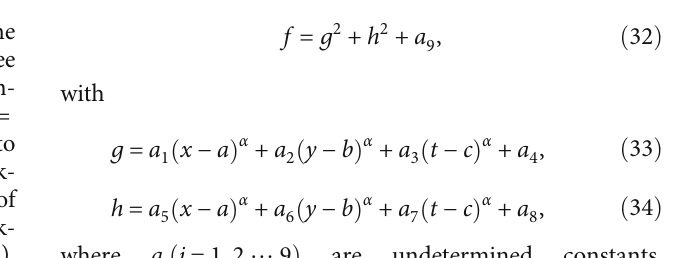
0 Þ = 0 , ξ ð 0 Þ = 0 , and ξ ð 0 Þ = 0 1 2 3